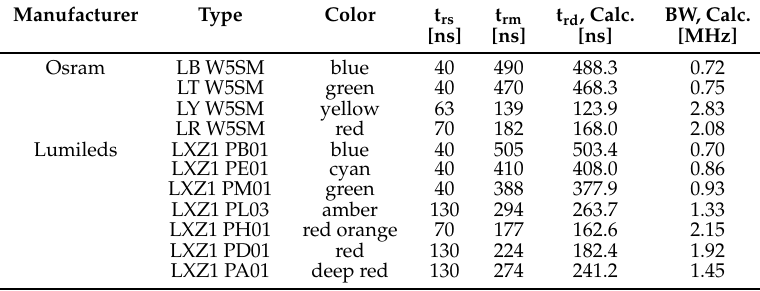
Table 4. LEDs used as photodetector, measured rise time t rm , calculated rise time t rd and calculated bandwidth BW, for TIA configured to approximately Q =